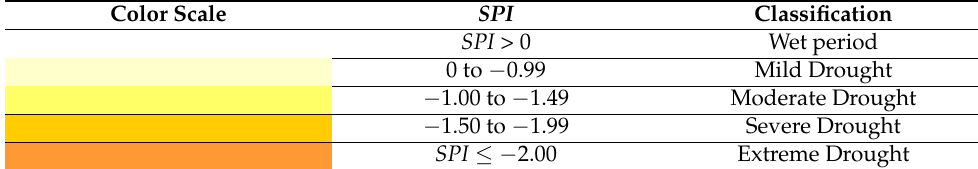
Table 1. Drought classification by SPI ranges [36,37].